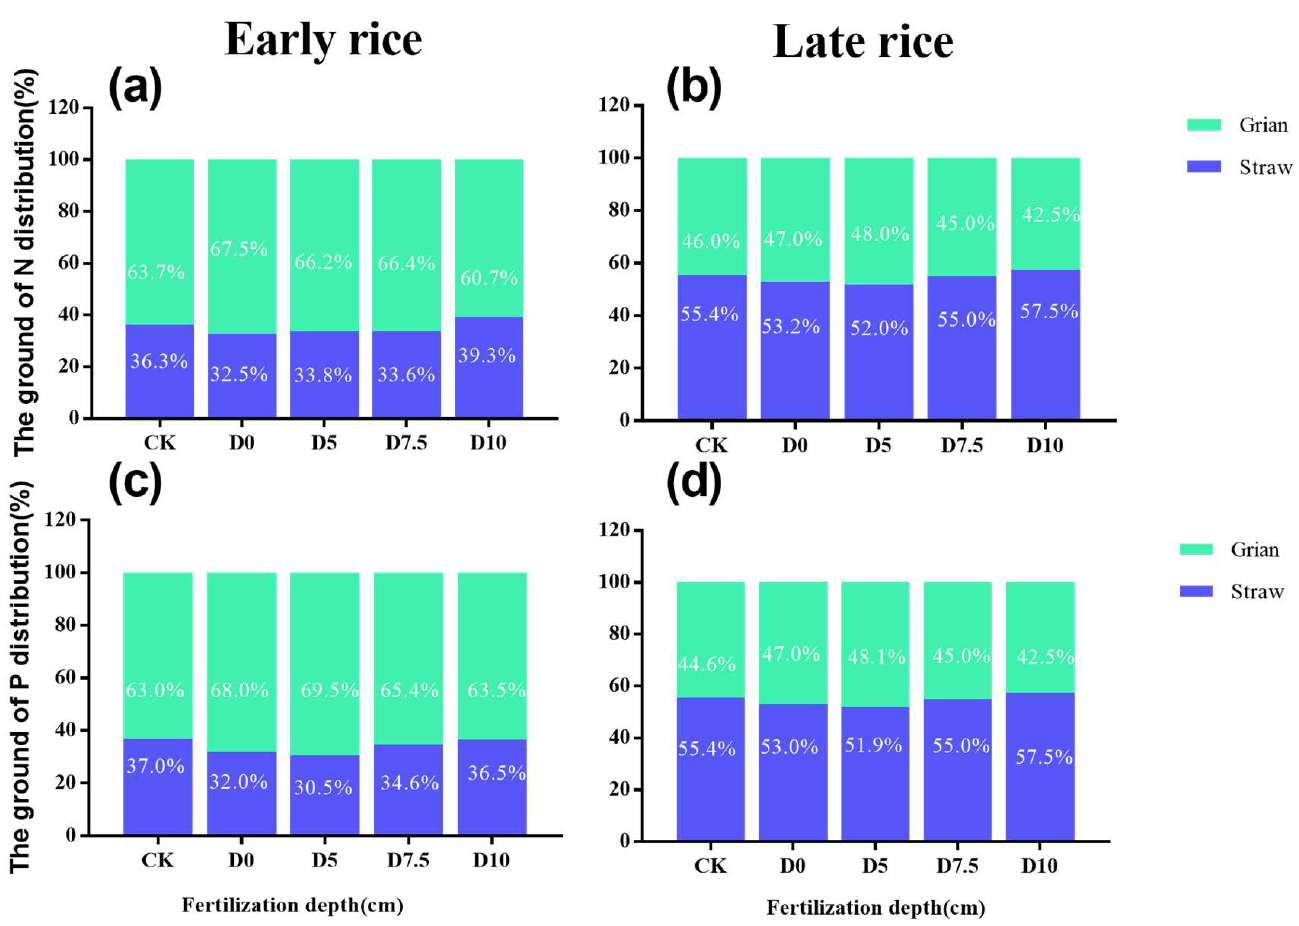
Figure 4. Nitrogen and phosphorus accumulation ratios in different parts of rice at harvest stage ； ( a ): Nitrogen accumulation ratio in different parts of rice in early rice. ( b ): Nitrogen accumulation ratio in different parts of rice in late rice. ( c ): Phosphorus accumulation ratio in different parts of rice in early rice. ( d ): Phosphorus accumulation ratio in different parts of rice in late rice. CK: no ferti- lizer; D0: surface spreading; D5: 5 cm side−deep fertilization; D7.5: 7.5 cm side−deep fertilization; D10: 10 cm side−deep fertilization.